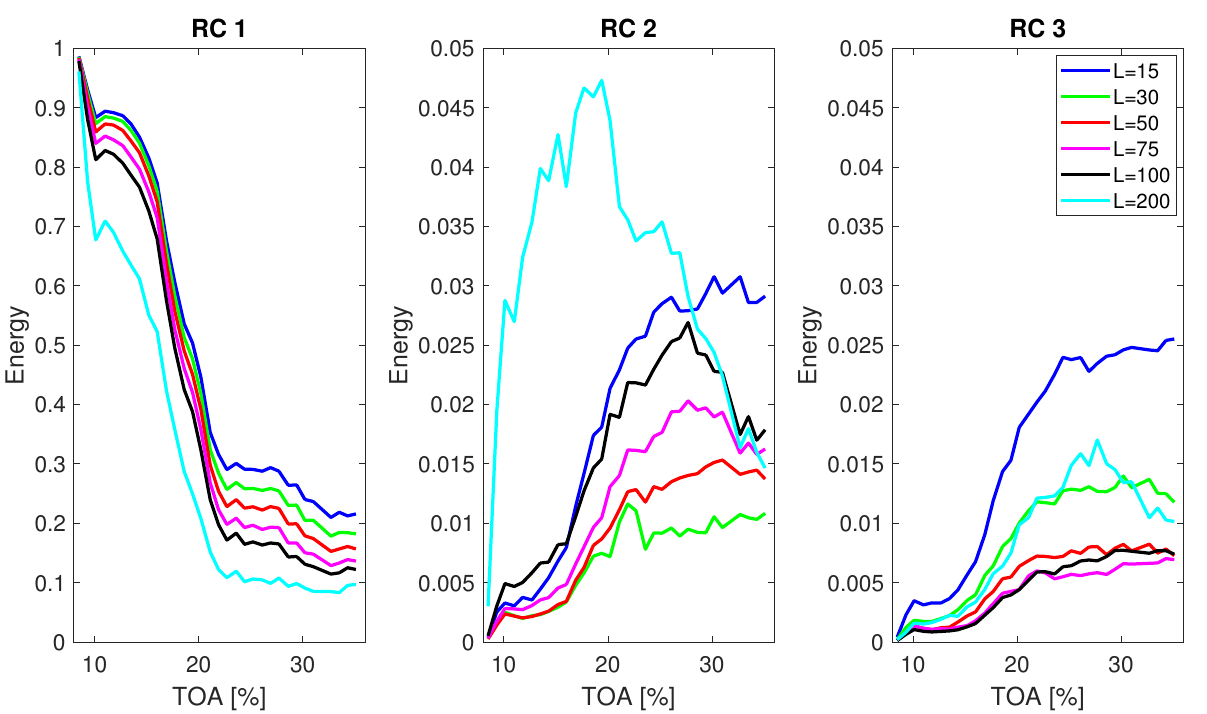
Figure 12. Mean energy E of RCs from 1 to 3 for varying window length and signal length N = 10,000.